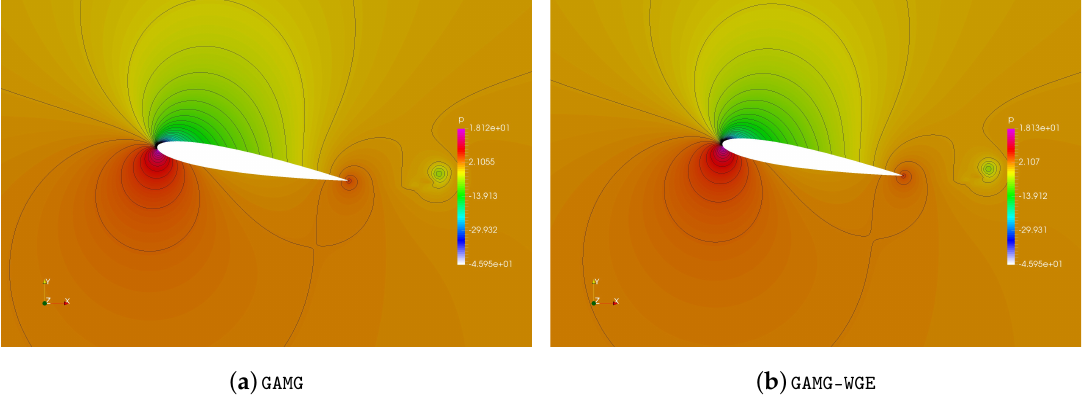
Figure 11. The distribution and contour of the p Rel field at 0.1 s using different methods in 2D NACA0012